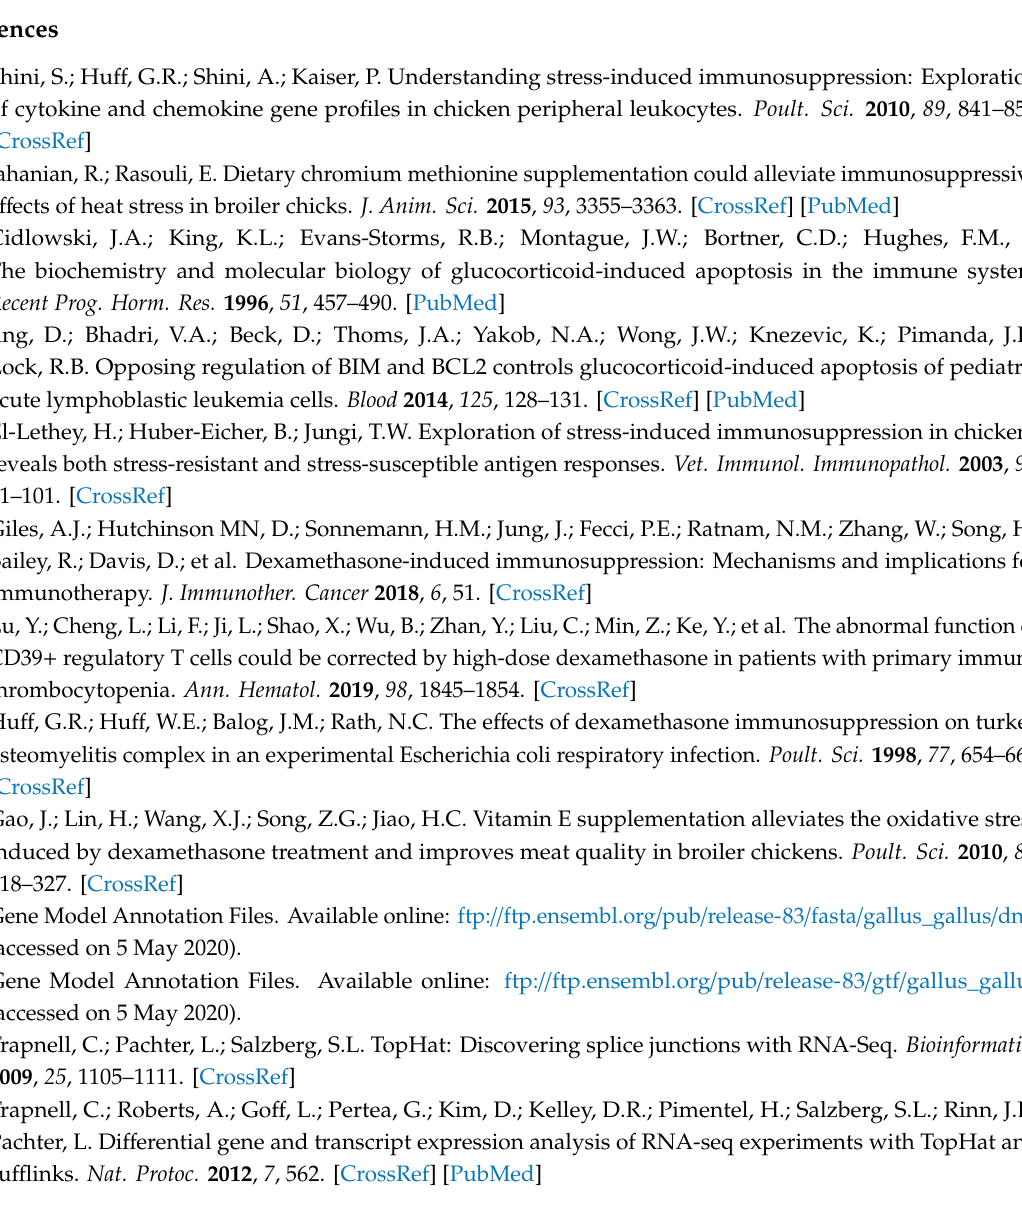
Table S1: E ff ects of Dexamethasone treatment on serum biochemical and immune indexes in chicks, Table S2: List of the genes and primers used for qRT-PCR validation, Table S3: The complete list of SDEGS, Table S4: The top 30 most enriched GO terms of SDEGS, Table S5: The top 20 KEGG pathways of SDEGs of D_S group and B_S group, Table S6: The FPKM values of RNA-seq data, Figure S1: The serum CORT levels of the two groups ( n = 9), Figure S2: The PPI network of the SDEGs, Figure S3: The module analysis of the SDEGs. Figure S4: Photomicrographs of hematoxylin and eosin stained chicken spleen section (A: B_S group; B: D_S